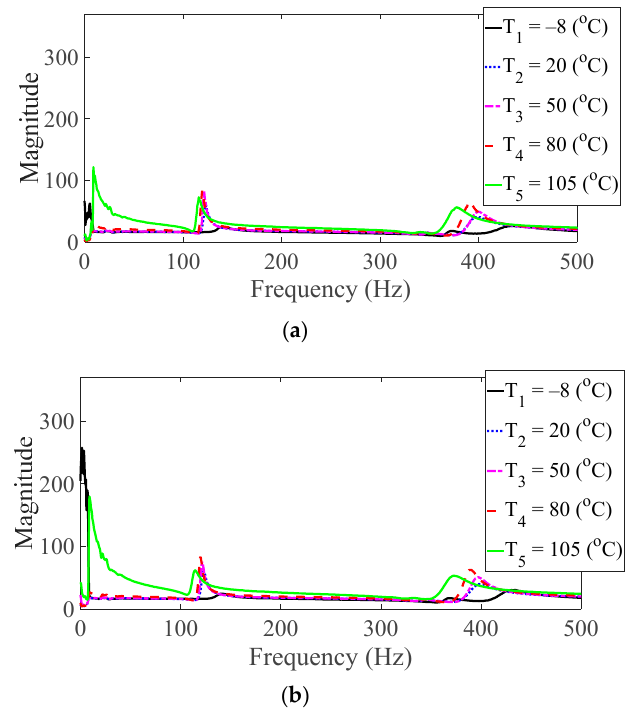
Figure 6. Measured FRFs with θ = 30°: ( a ) p = harmonic and ( b ) p = random.